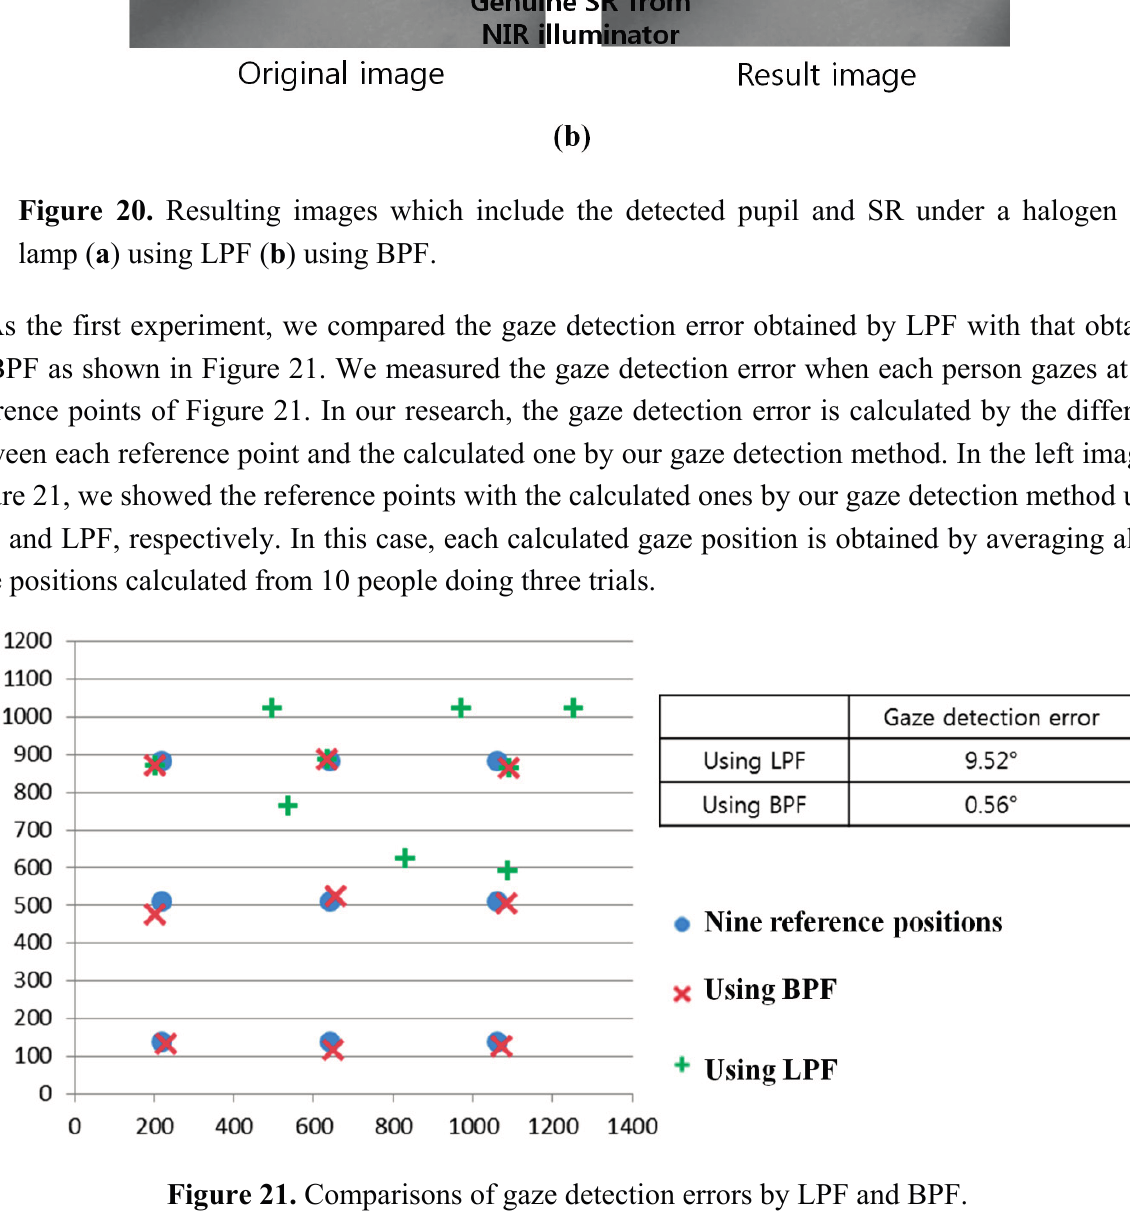
Figure 21. Comparisons of gaze detection errors by LPF and